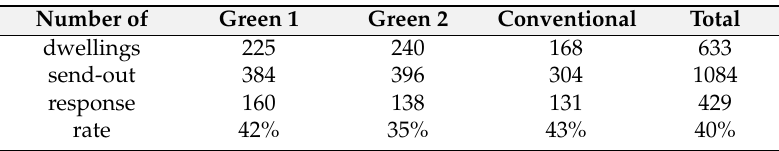
Table 1. Response